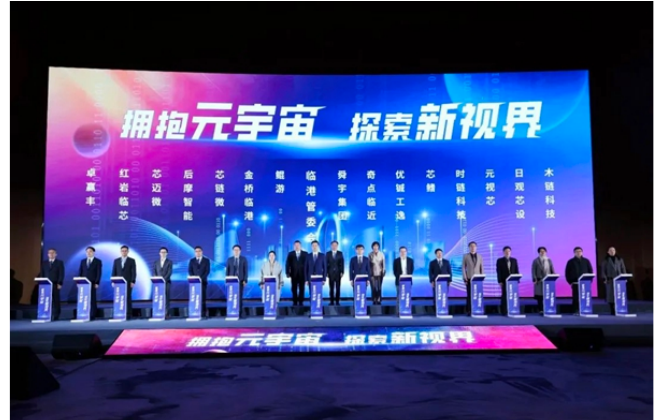
Figure 6: Shanghai’s XR Conference 2023, discussing China’s